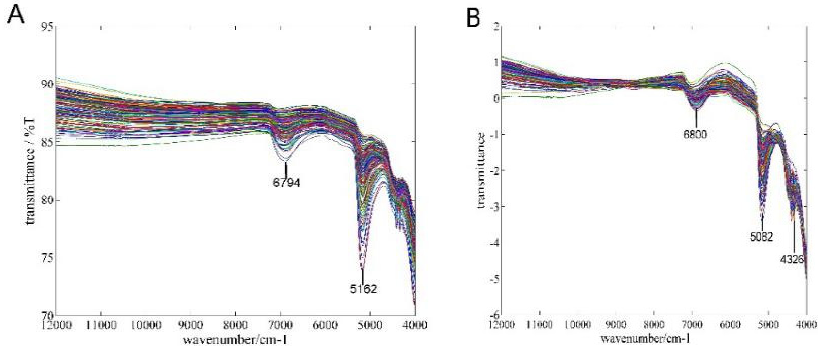
Figure 1. Spectra of samples: ( A ) RAW spectra and ( B ) SNV spectra.